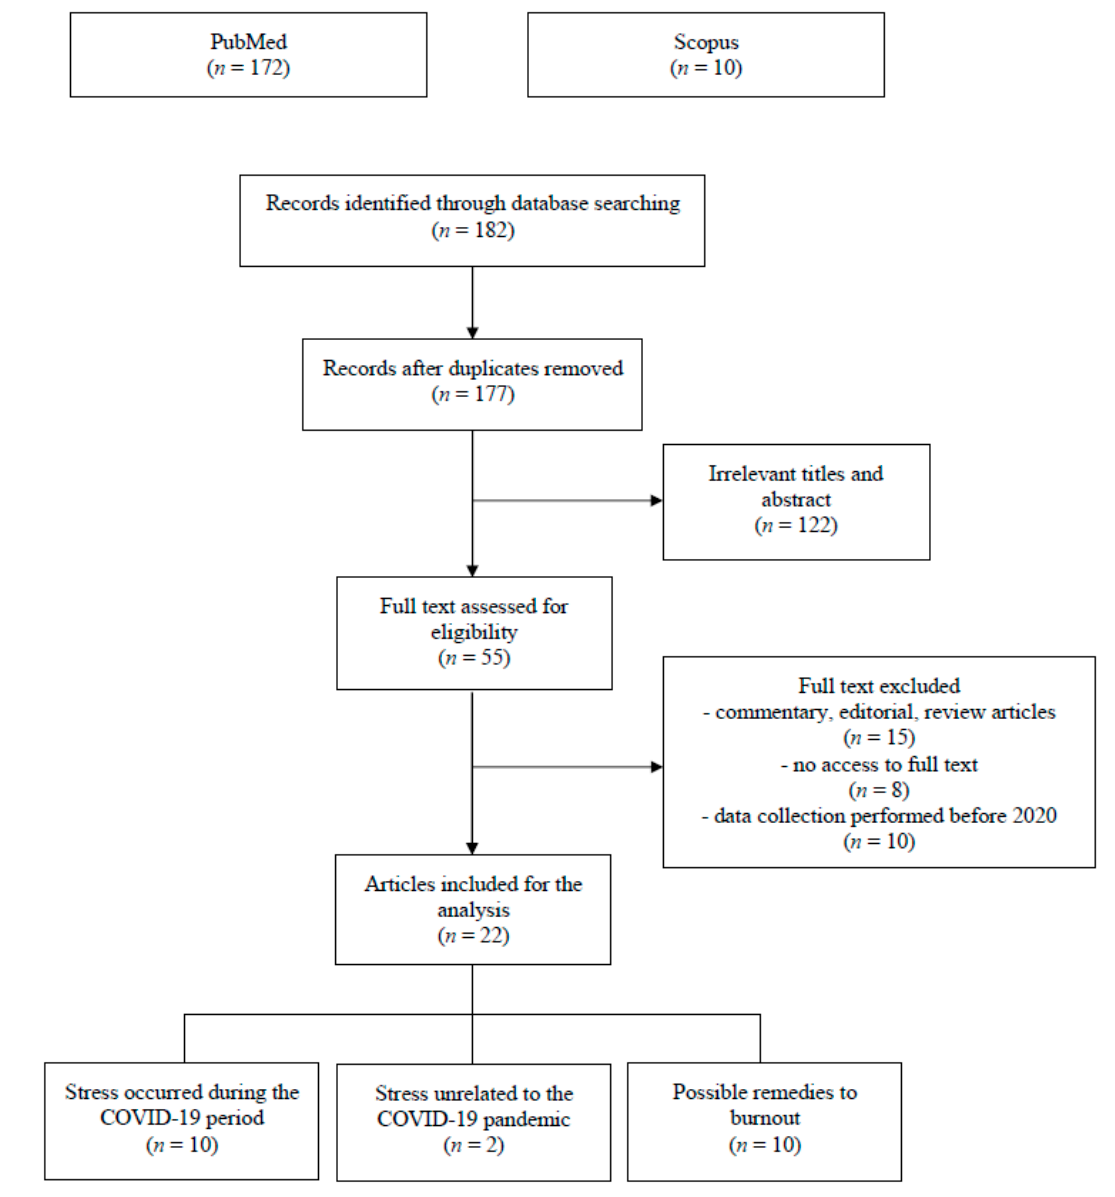
Figure 1. PRISMA flow chart illustrating the inclusion and exclusion criteria for the article search.